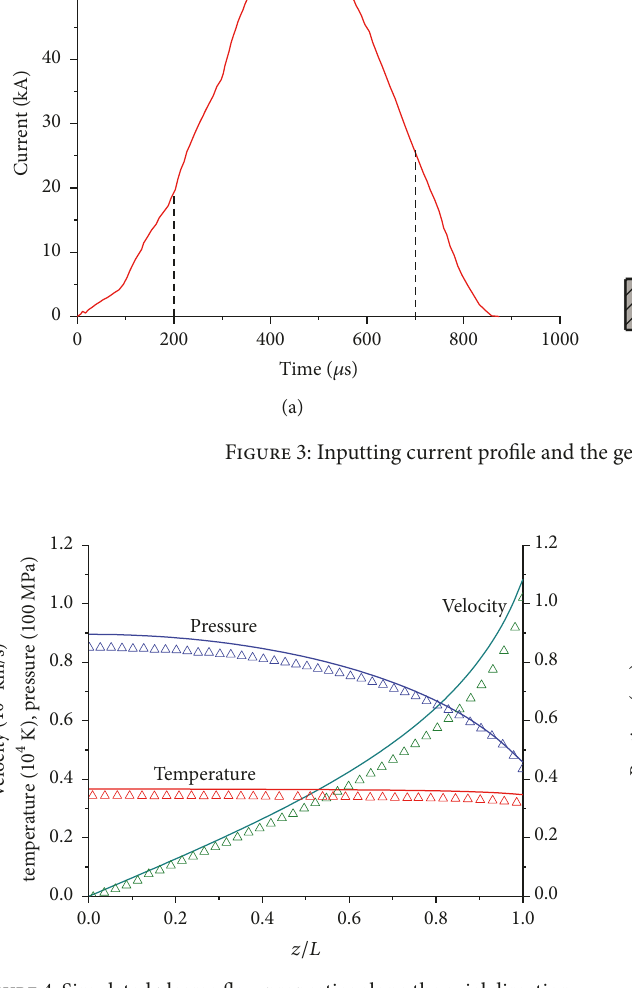
Figure4:Simulatedplasmaflowpropertiesalongtheaxialdirection at 500 𝜇 s. 𝐿 is the total length of computational region ( 𝐿 = 60.9 mm). Solid lines represent the results from present calculations and symbols represent the results from [4].